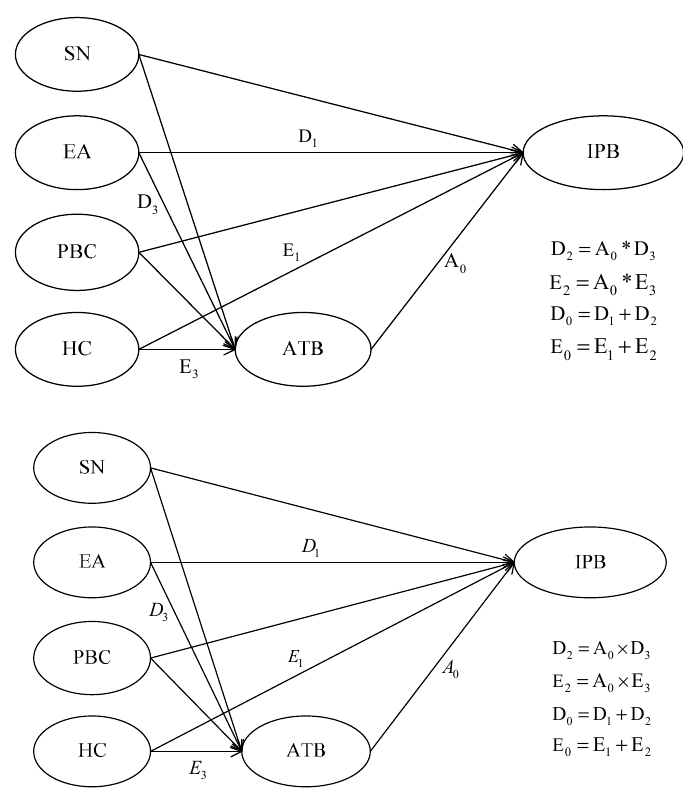
Figure 3. A Simplified Conceptual Framework.